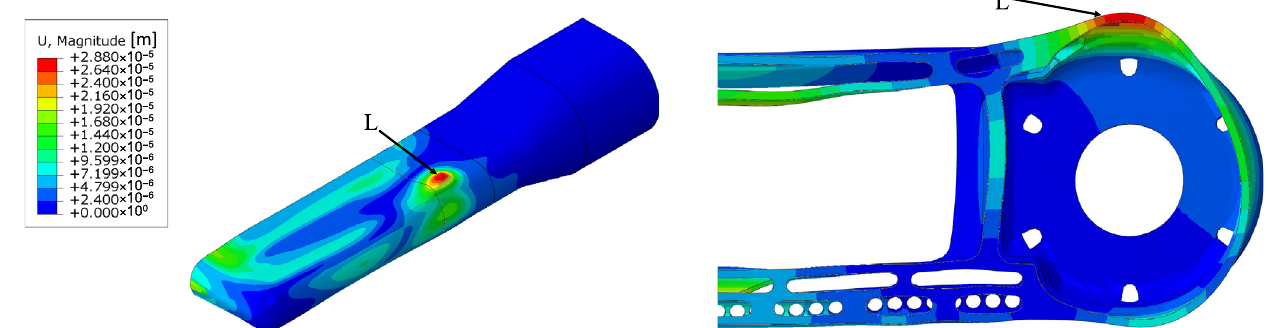
FIG. 23. Deformed shape (magnified 500 ×) of the front body at sensor L at 2.1